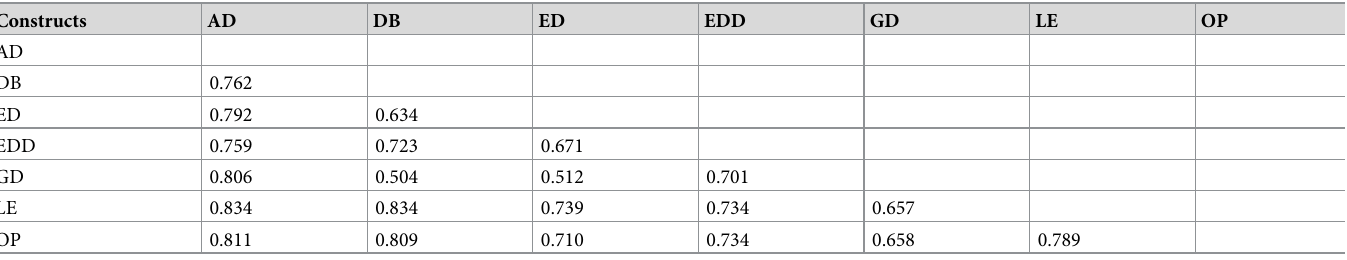
Table 4. HTMT values.